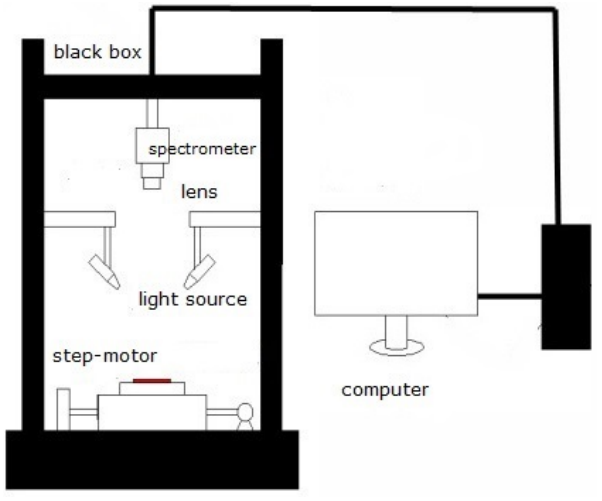
Figure 2. Schematic diagram of the hyperspectral imaging system. The system consists of a black box, spectrometer, lens, light source, step-motor and computer.